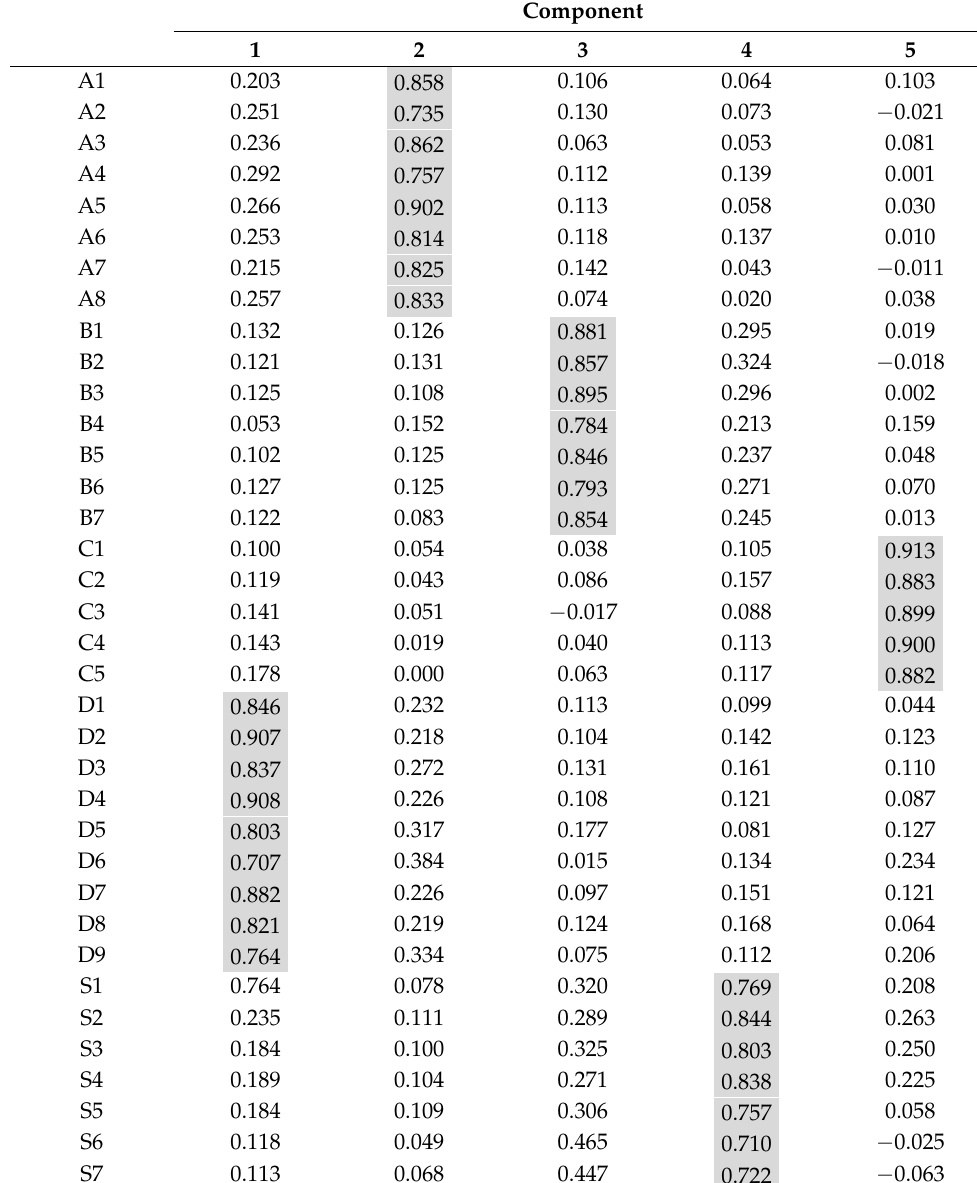
Table 3. Rotated component